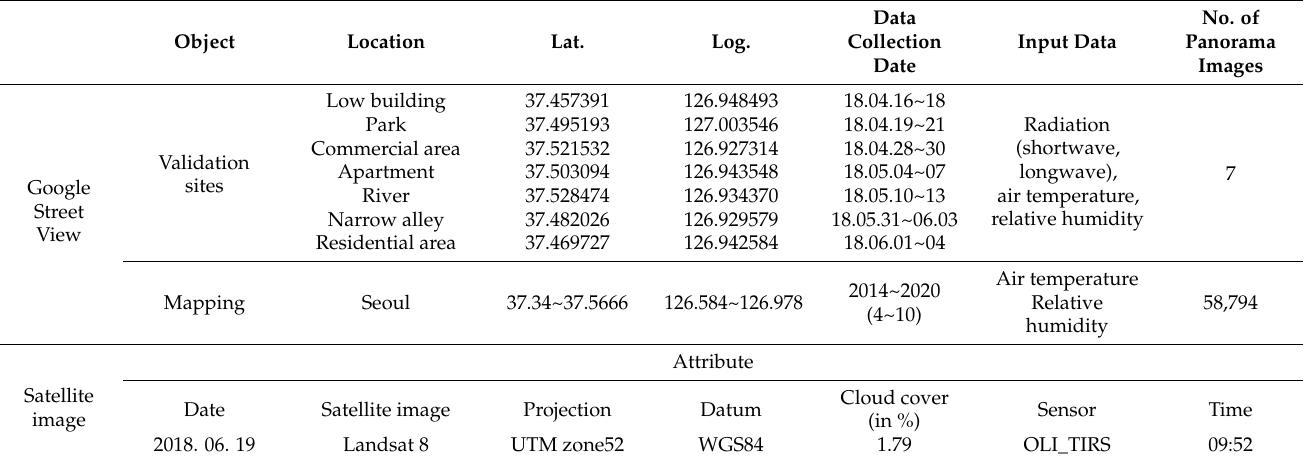
Table 1. Study area for verification and application in each 2018–2020. Latitude (Lat.) and Longitude (Log.) were used for collecting panorama